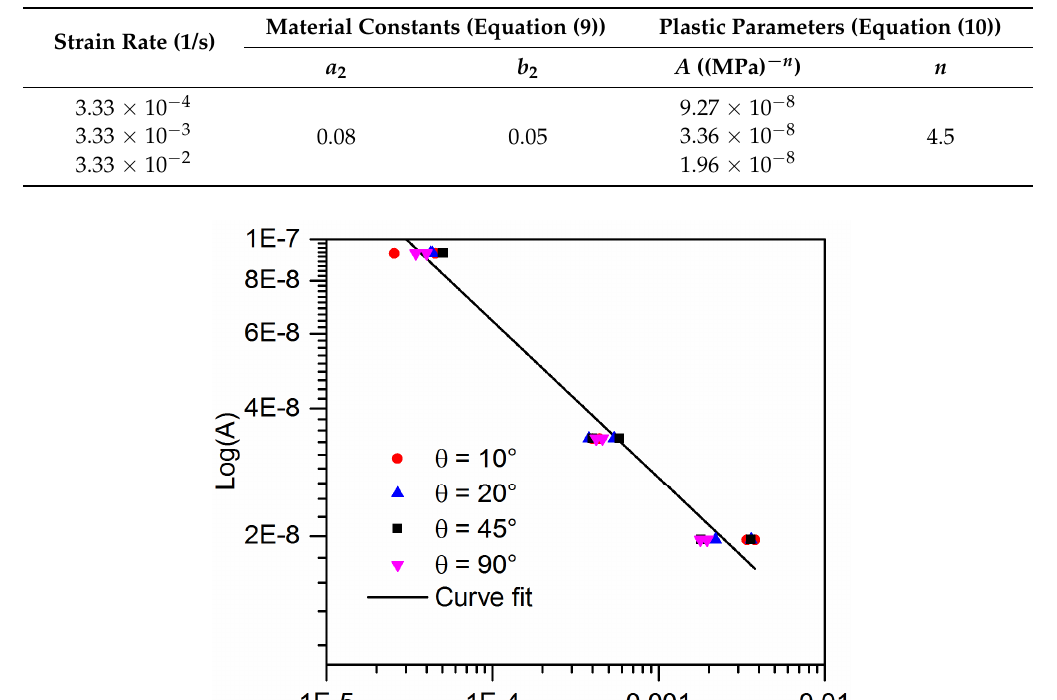
Table 2. Plastic parameters for quasi-UD E-glass/PP composite at three different strain rates.